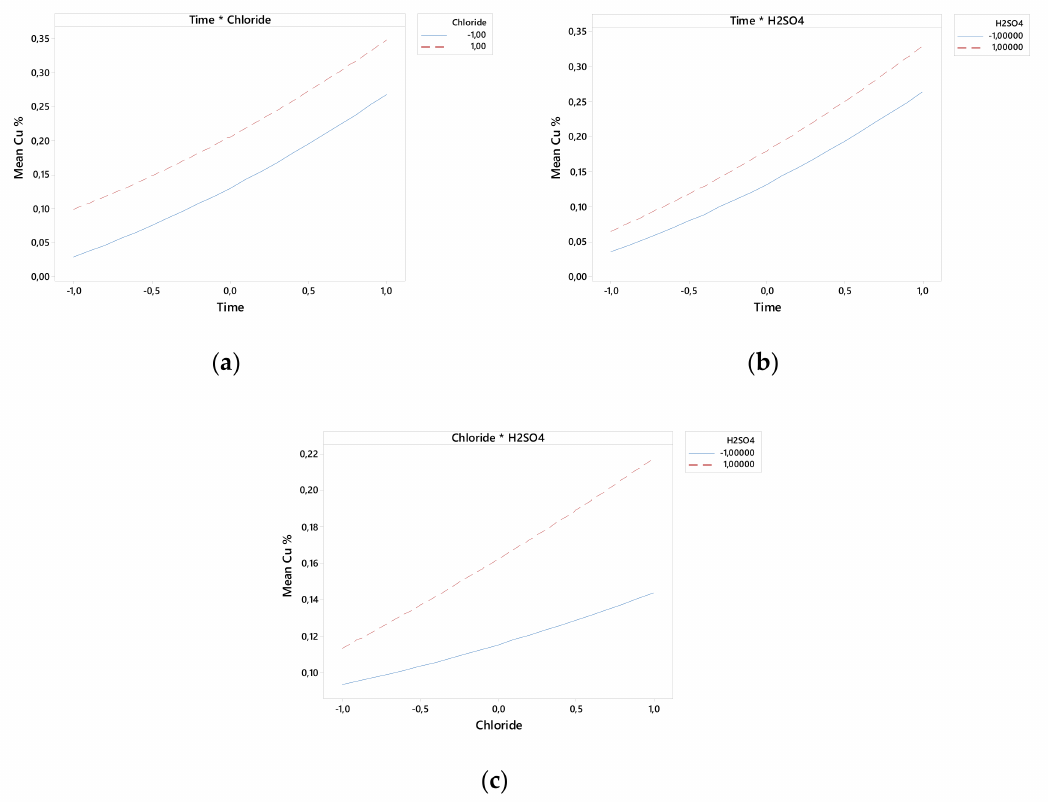
Figure 3. Interactions of time–chloride ( a ), time–H 2 SO 4 concentration ( b ), and chloride–H 2 SO 4 ( c ) on Cu